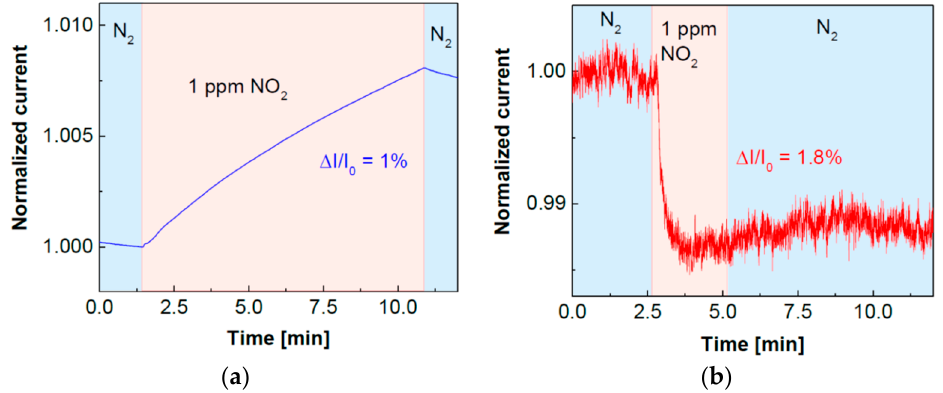
Figure 2. Dynamic current behaviour of the sensors, where the current is normalised to the value at the gas inlet. ( a ) pristine sensor; ( b ) sensor functionalised with